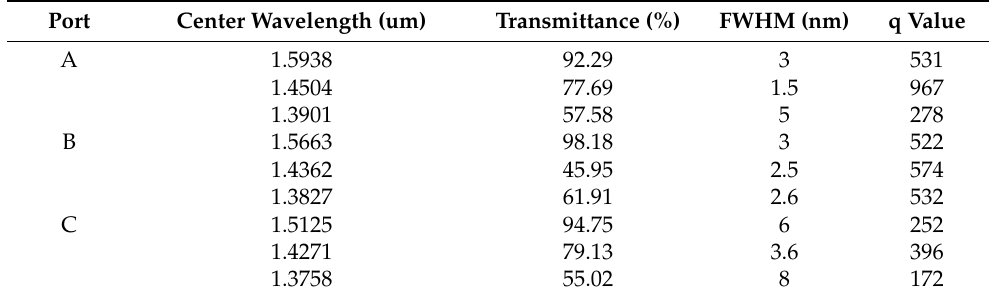
Table 2. Download efficiency, FWHM, and q values of each channel of the filter for different